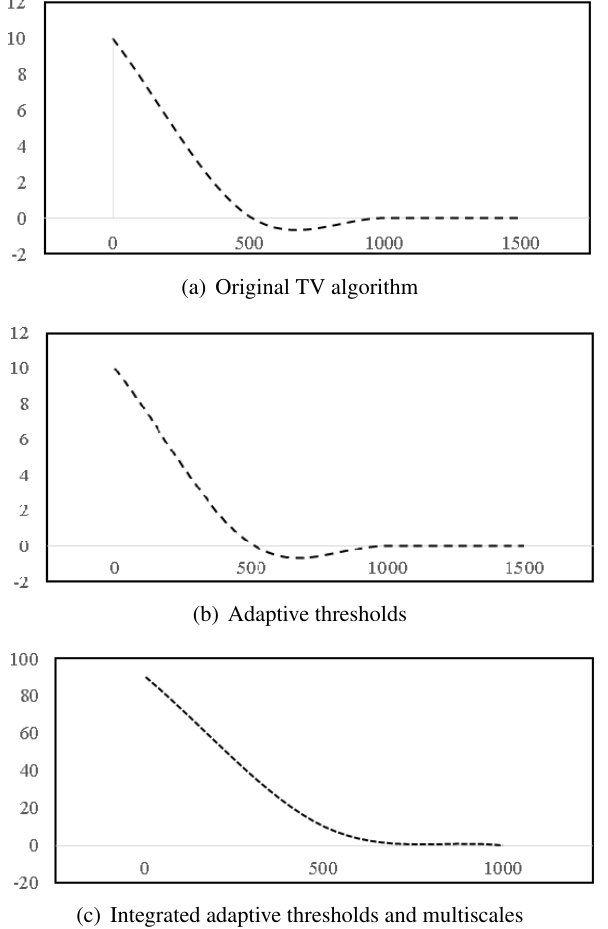
Fig. 3 Curve change diagram of image change. Table 1 The number and time of iterations required by CDD and FCDD models Bar The ring Face LAKE